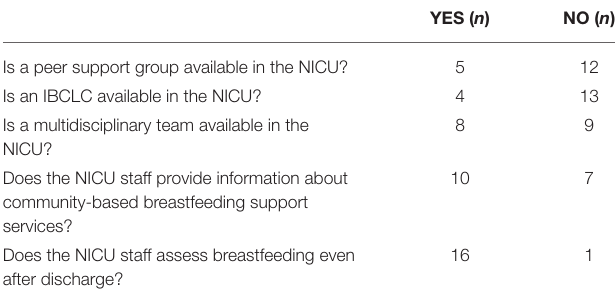
TABLE 6 | Breastfeeding promotion and